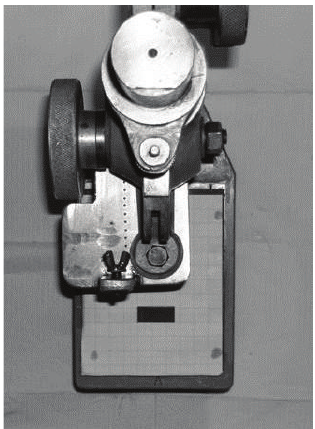
Figure 2: Stand to maintain a digital camera and the sections in a repeatable